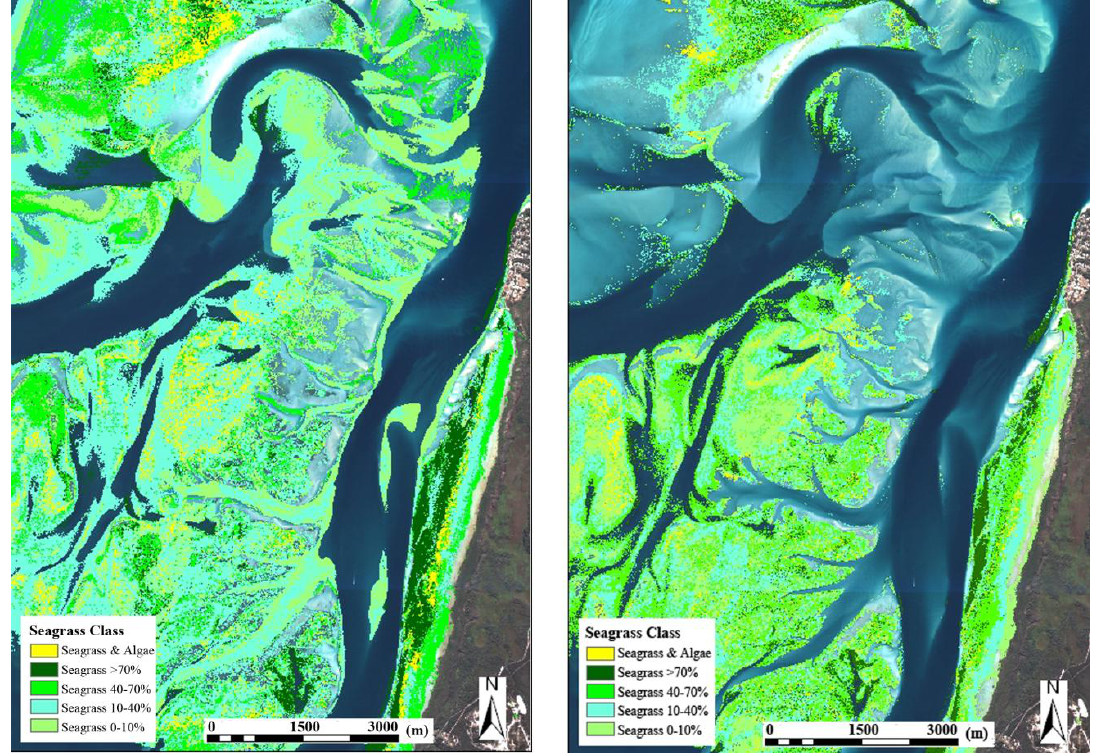
Figure 4. Seagrass percentage cover map produced for 2004 (left) and 2007 (right)